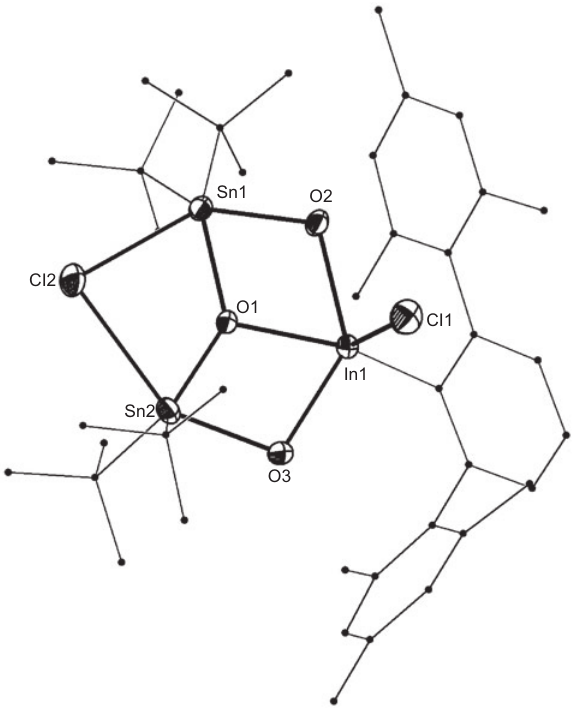
Figure 1 Molecular structure of 1 showing 20 % probability ellip- soids and the crystallographic numbering